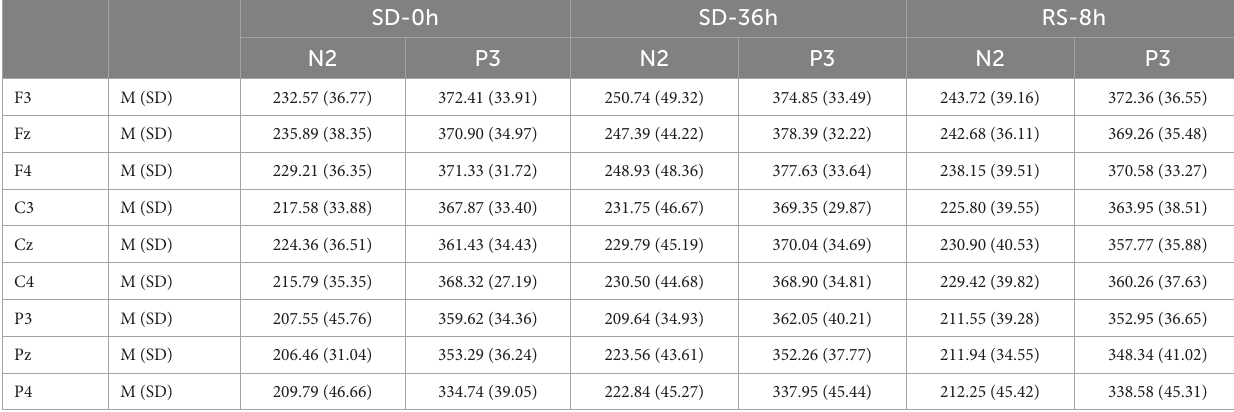
TABLE 5 Grand-average peak latency of the N2 and P3 components for correct responses across multiple electrode sites in three sleep states in the sleep deprivation (SD) group.